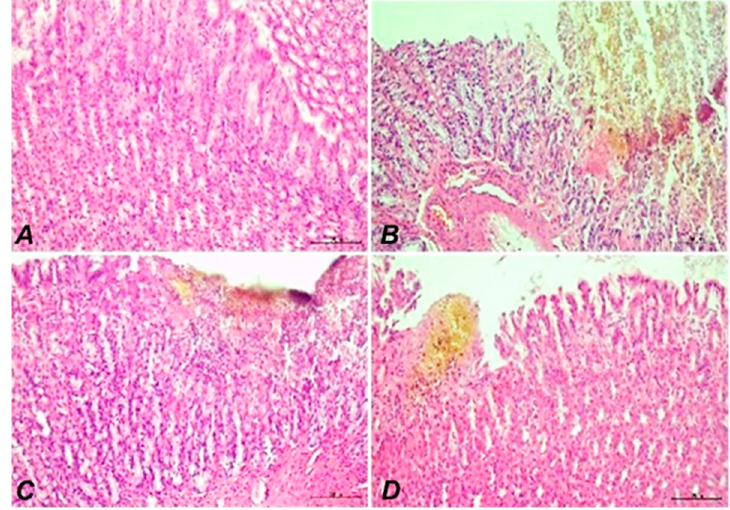
Figure 3. Photomicrographs showing the effect of CA on stomach sections of IND-administered rats stained with haematoxylin–eosin. (H&E) ( A ) Stomachs of negative control rats, ( B ) IND-administered rats ( C ), IND-administered rats pretreated with ESP (20 mg/mL) (IND + ESP) ( D ) and IND-administered rats pretreated with CA. IND: Indomethacin, ESP: Esomeprazole, CA: Carnosic acid. Bar: 100 μ m. Table 2. Effects of CA on IND-induced microscopic gastric injuries.